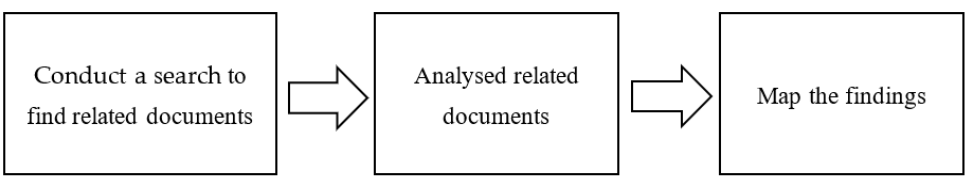
Figure 1. Approach design.